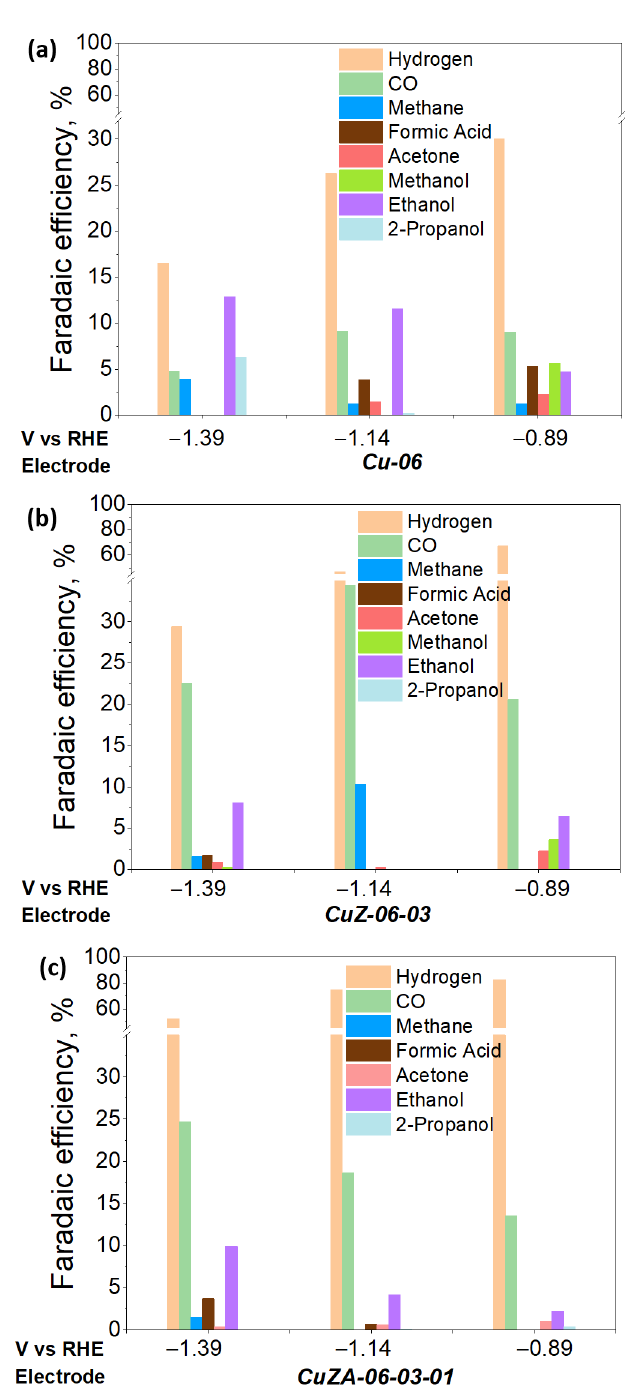
Figure 12. Faradaic efficiencies for CO 2 reduction products on Cu-06 ( a ), CuZ-06-03 ( b ) and CuZA- 06-03-01 ( c ) electrodes at − 1.39, − 1.14 and − 0.89 V vs. RHE.